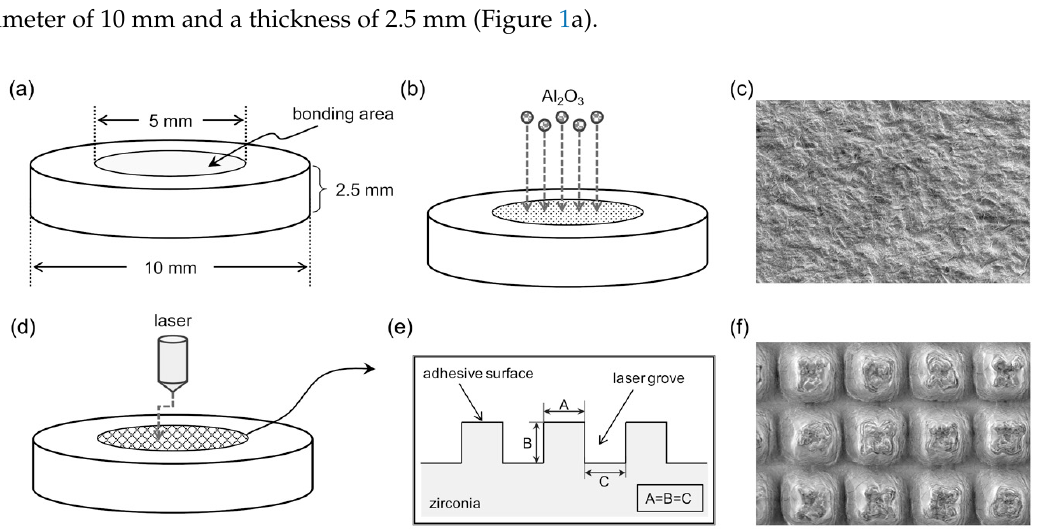
Figure 1. Schematic illustrations of the specimens. The design of the zirconia ceramic disk-shaped specimens with the bonding area at the middle of the specimens ( a ). Two different surface treatments of zirconia ceramic groups: (1) air-abrasion treatments (control (CON)) with 50 µ m alumina particles (Al 2 O 3 ) and 0.3 MPa jet pressure for 10 s with the distance from the orifice to the zirconia surface of 10 mm ( b ), and the scanning electron micrograph (SEM) of the specimen surface ( c ); (2) Nd: YVO 4 laser treatments ( d ), an isometric grid pattern (A = B = C) with groove dimensions of 50, 75, and 100 µ m ( e ), and SEM of the specimen surface ( f ).